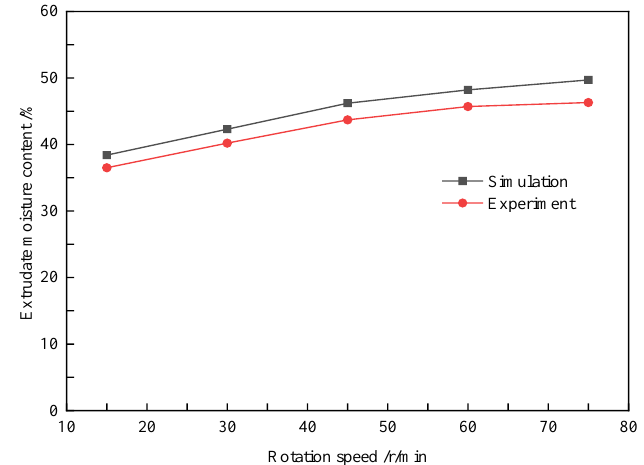
Figure 4. Material comparison before and after experiment. ( a ) Before the experiment. ( b ) After the experiment.